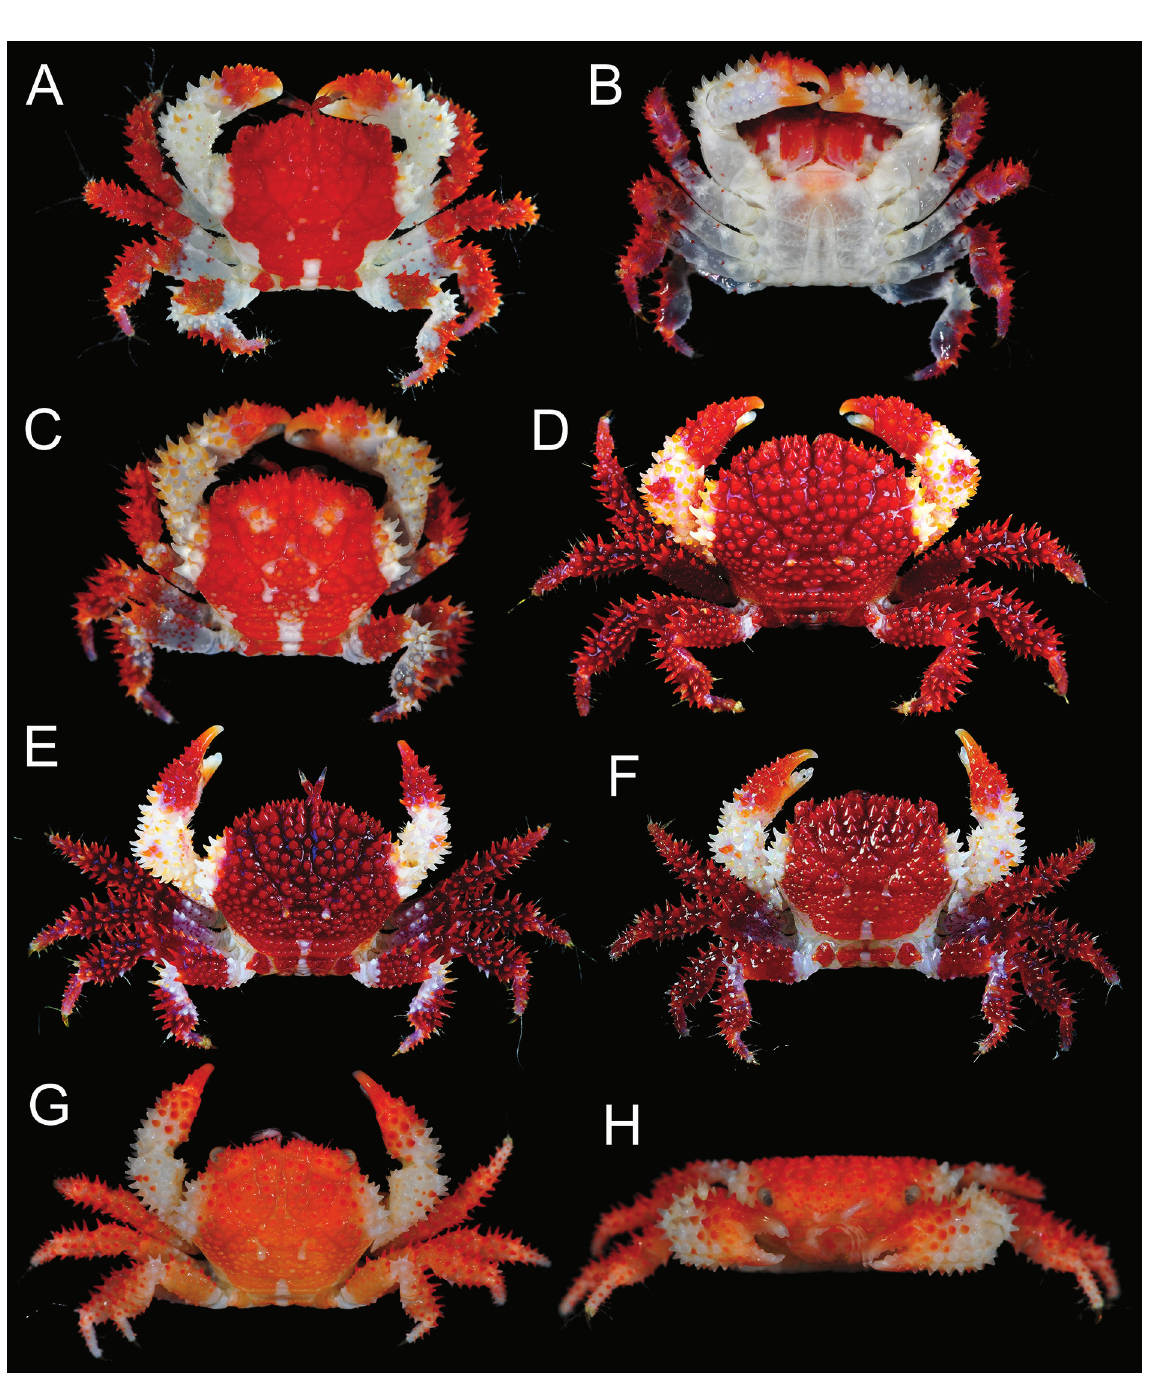
Fig. 1. Actaea grimaldii sp. nov., Papua New Guinea, colours in life. A – B . Paratype, ♂, 5.1 × 3.8 mm (ZRC, ex MNHN IU 2013-920). C . Holotype, ♂, 6.2 × 4.4 mm (MNHN IU 2013-921). D . Paratype, ♀, 10.2 × 7.8 mm (ZRC, ex MNHN IU 2013-1245). E . Paratype, ♀, 8.5 × 6.2 mm (MNHN IU 2013-222). F . Paratype, ♀, 6.7 × 4.9 mm (MNHN IU 2013-759). G – H . Paratype, ♀, 6.4 × 4.9 mm (ZRC, ex MNHN IU 2013-1255). A–G, dorsal views of habitus; B, ventral view of habitus; H, frontal view of